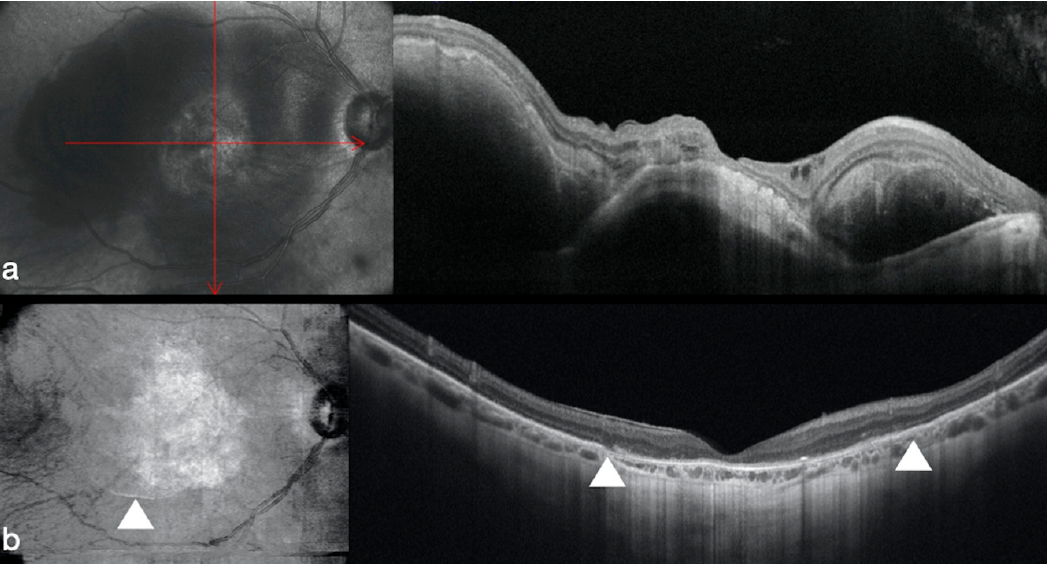
Figure 3. Preoperative OCT showing a sub macular hemorrhage involving the posterior pole ( a ) 6 months postoperative OCT shows a sub-retinal hAM patch positioned at the posterior pole (white arrows). We can recognize the outer retinal layers such as the external limiting membrane and ellipsoid zone ( b ).